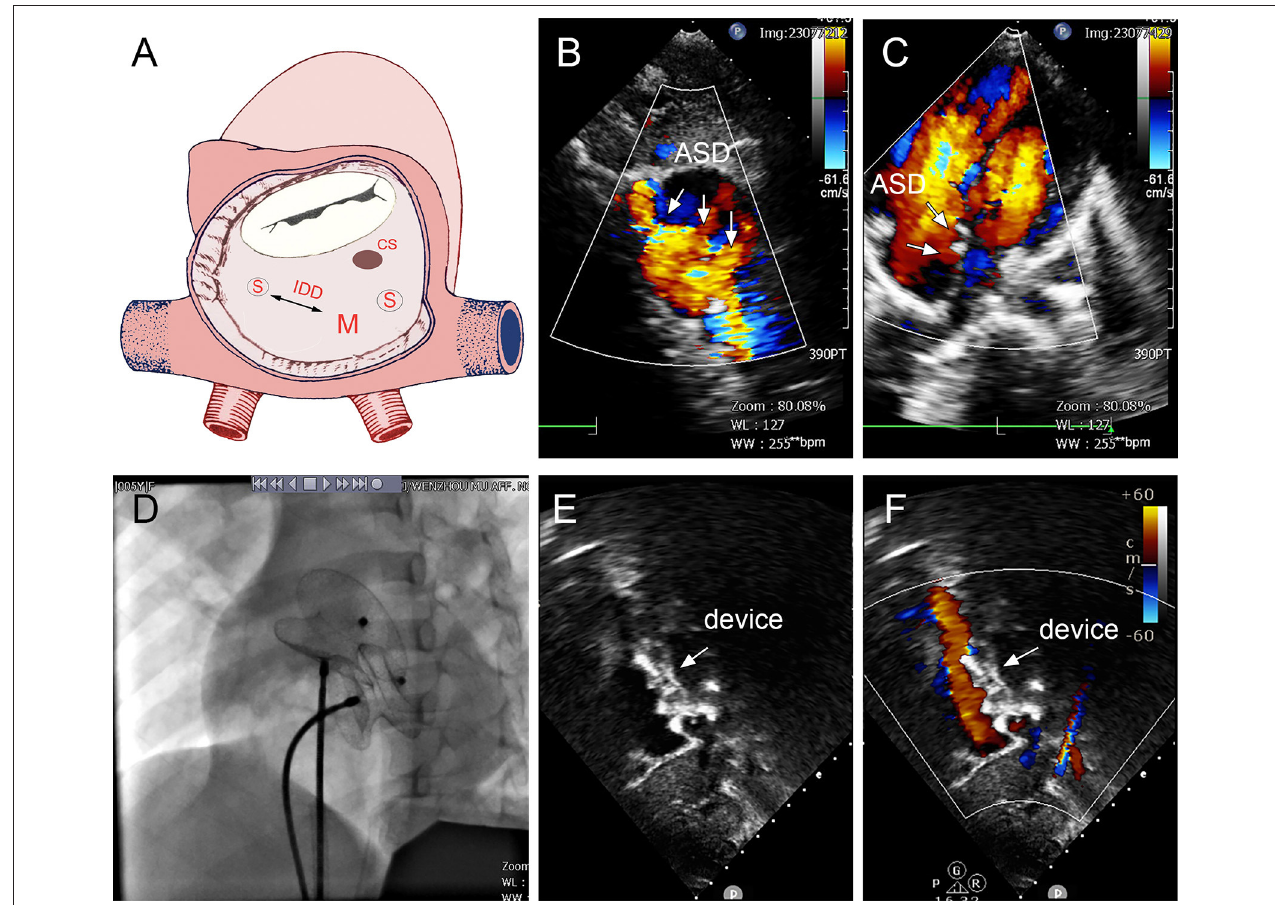
FIGURE 6 | Group C: a 5-year-old girl; the TTE showed three defects (15, 2, and 5mm); the distance between the largest and smallest hole was 14mm (A–C) . The 16- and 22-mm MemoPart ASDOs were implanted (D) , and no residual shunt (E,F) and any complication happened from immediate postoperation last follow-up. ASD, atrial septal defect; IDD, interdefect distance; CS, coronary sinus; S, small ASD; M, moderate ASD.